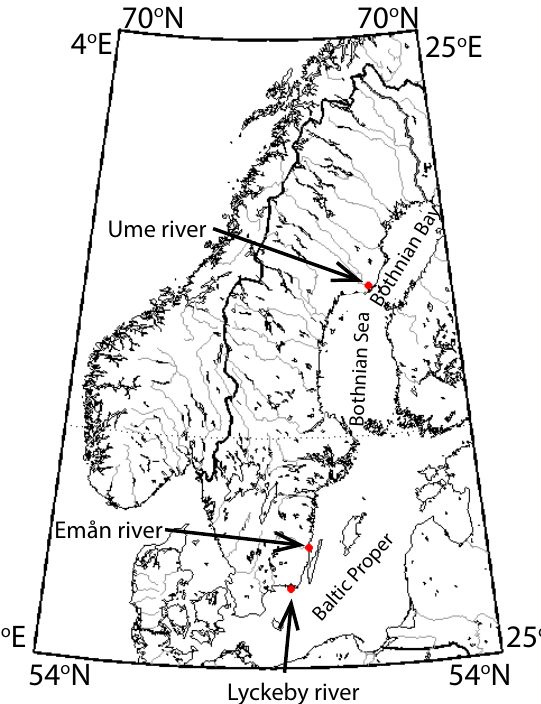
Figure 1. Map of catchments locations. From north to south: Ume river, Emån river, Lyckeby